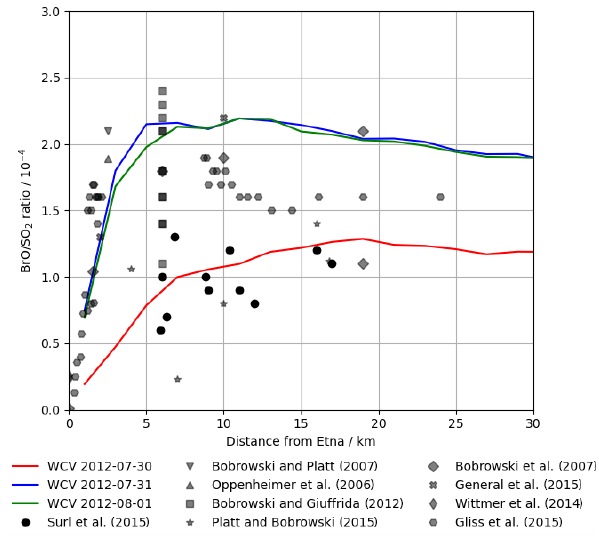
Figure 11. Modelled BrO / SO 2 ratio at 12:00UTC on 30 July 2012, 31 July 2012, and 1 August 2012 (lines) and observed BrO / SO 2 ratios in Etna plumes from several studies (markers), plotted against distance from the volcano. We cau- tion that these observations, taken on several days with varying wind speeds, should not be interpreted as representing temporal evolution.